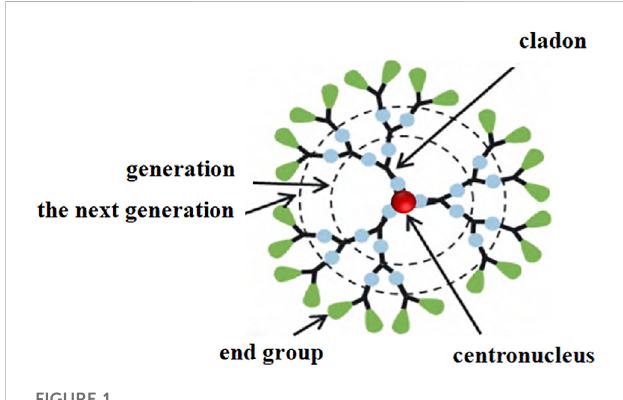
FIGURE 1 Schematic of the basic structure of the tree